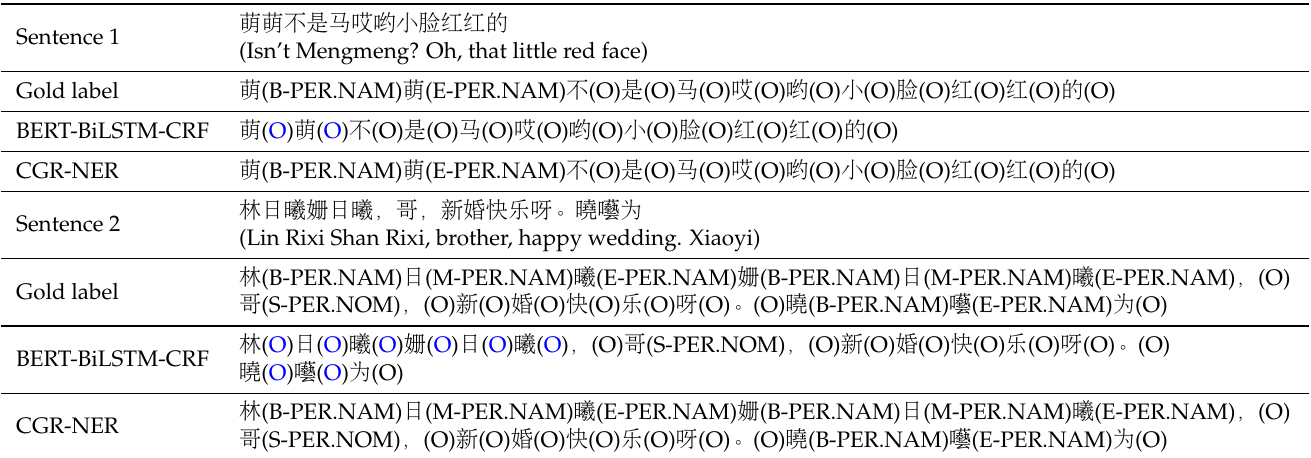
Table 12. Entity recognition results of NER model. Blue represents error recognition